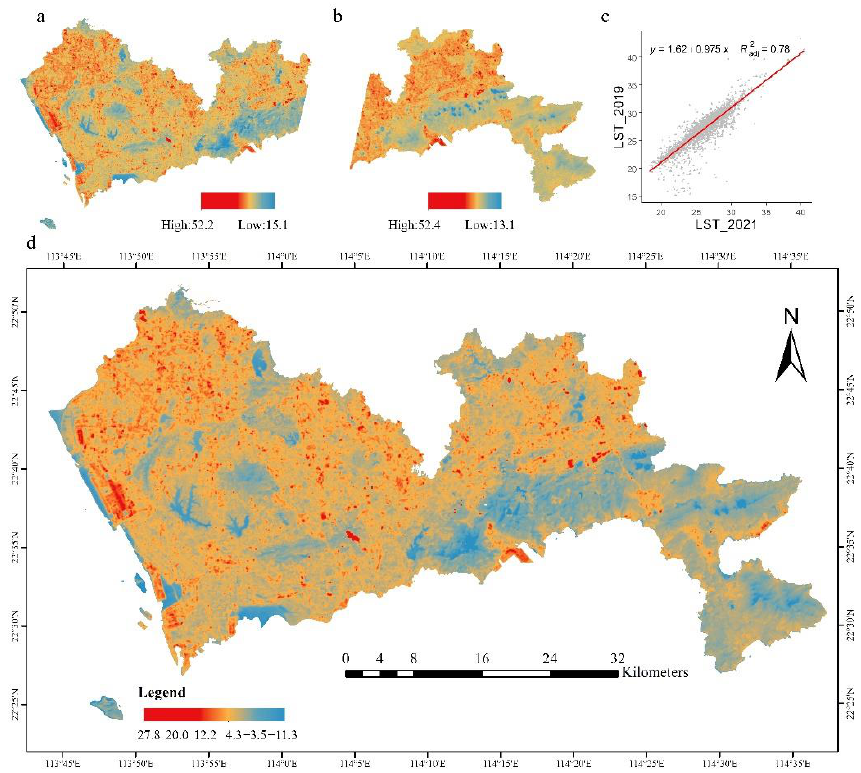
Figure 6. Urban surface temperature results in Shenzhen. ( a ) land surface temperature retrieved from scene LC81220442021035LGN00; ( b ) land surface temperature retrieved from scene LC81210442019071LGN00; ( c ) scatter plot and regression between (land surface temperature) LST of the overlap region in 2019 and 2021. ( d ) Distribution of differential surface temperature (DST)(°C).